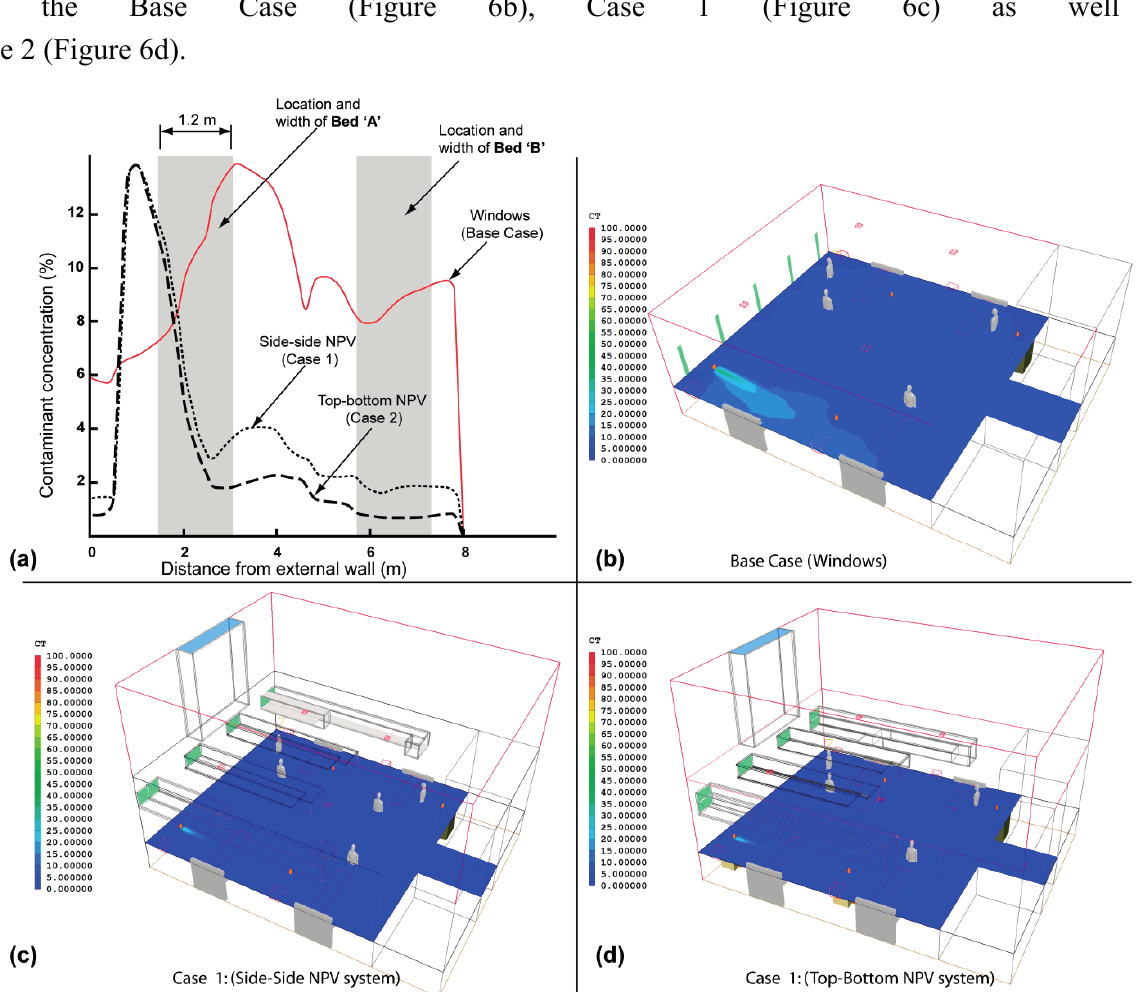
Figure 6. Predicted contaminant (CT) concentration results for: ( a ) All three cases at height of 1.05 m along trajectory of release; and 2D horizontal axis contours for ( b ); Base Case ( c ) Case 1; and ( d ) Case